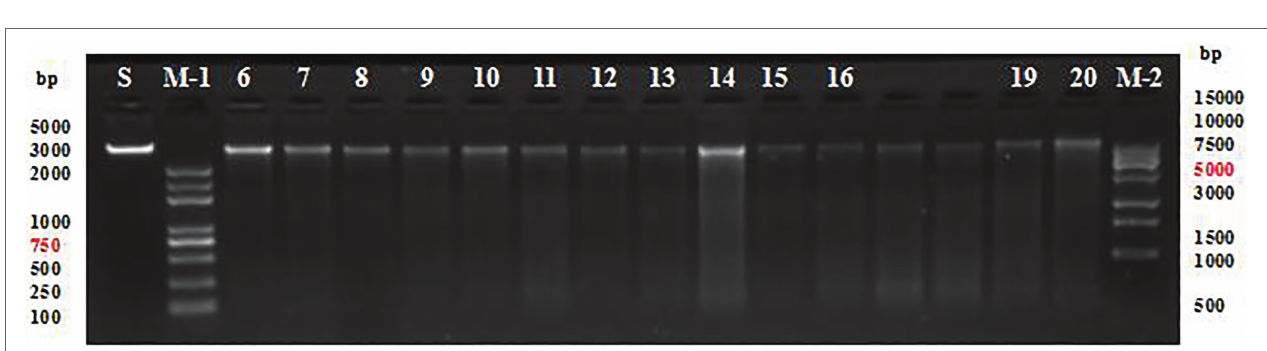
FIGURE 2 | Agarose gel electrophoresis of DNA fragments from populations 1 and 2. S, standard sample; M-1, trans 5k DNA marker; M-2, trans 15k DNA marker; and 6–20, partial maize